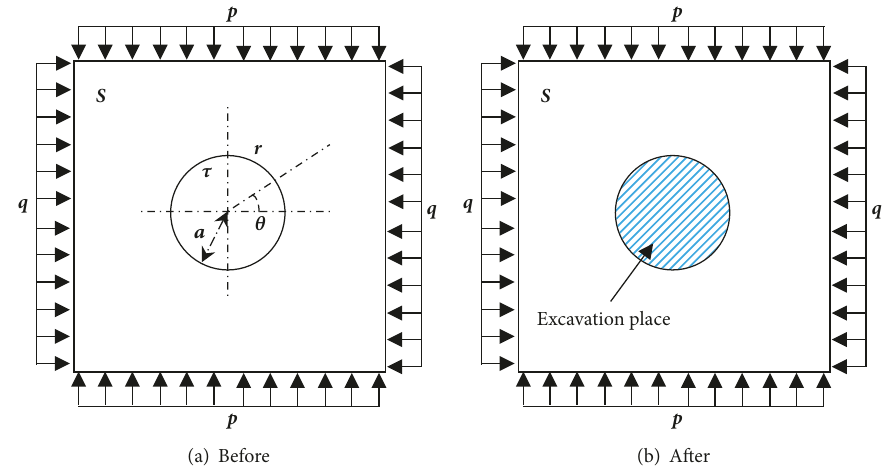
Figure 11: Stress experienced by the tunnel model before and after excavation.